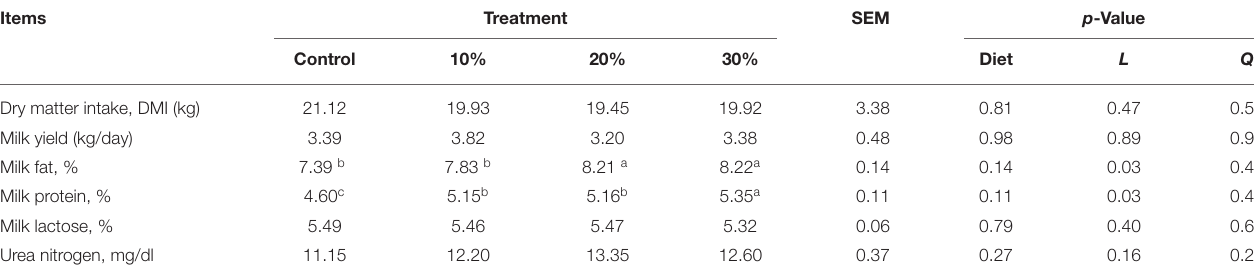
TABLE 11 | Effects of rape silage inclusion on dry matter intake (DMI) and milk composition of lactating buffaloes. Items